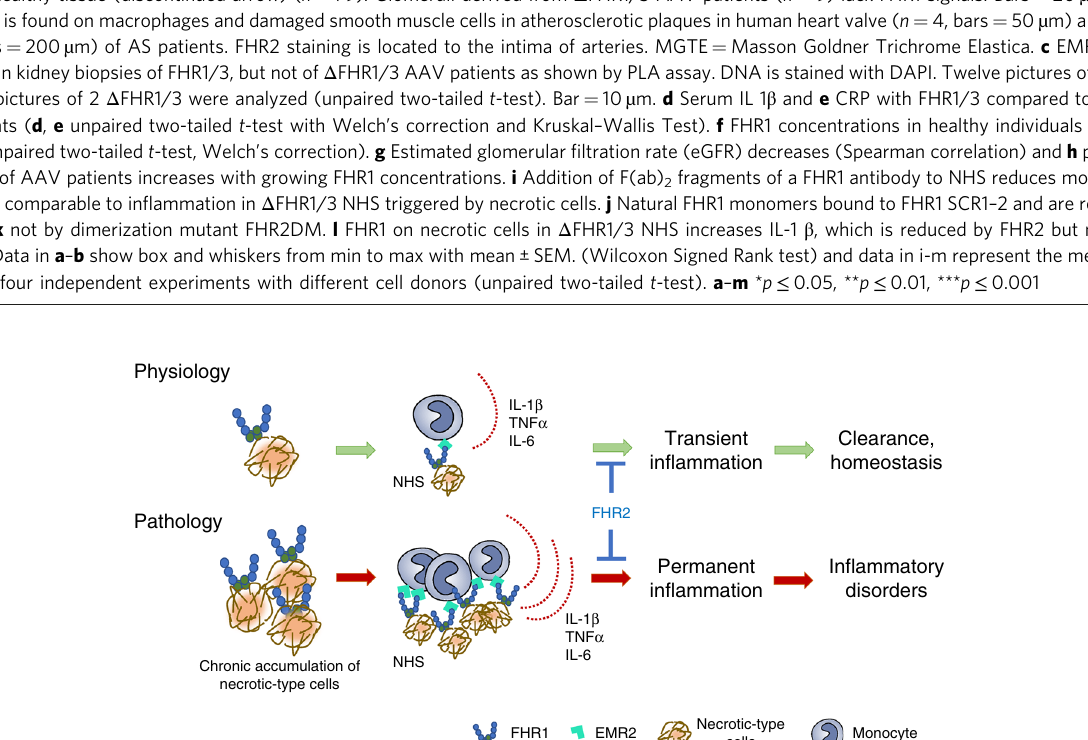
Fig. 8 Overview. FHR1 binds to necrotic-type cells and induces in fl ammation in monocytes in NHS. Accumulation of necrotic-type cells recruits FHR1, which over-activates monocytes and induces in fl ammatory